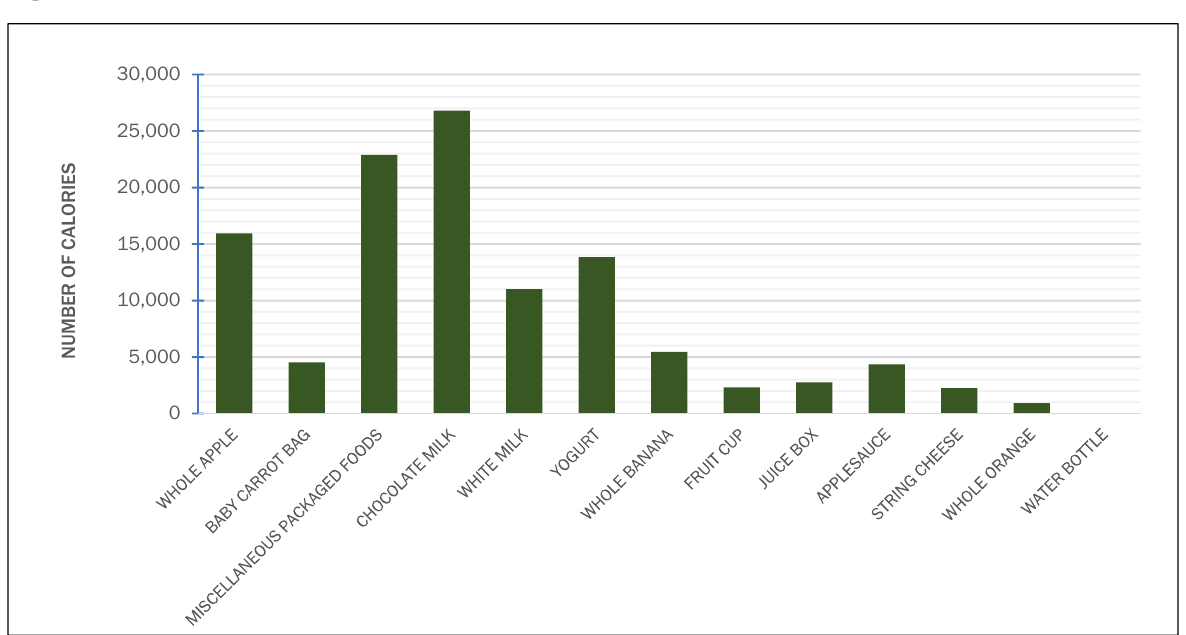
Figure 8. Estimated Total Calories Wasted from Rescuable Food Items